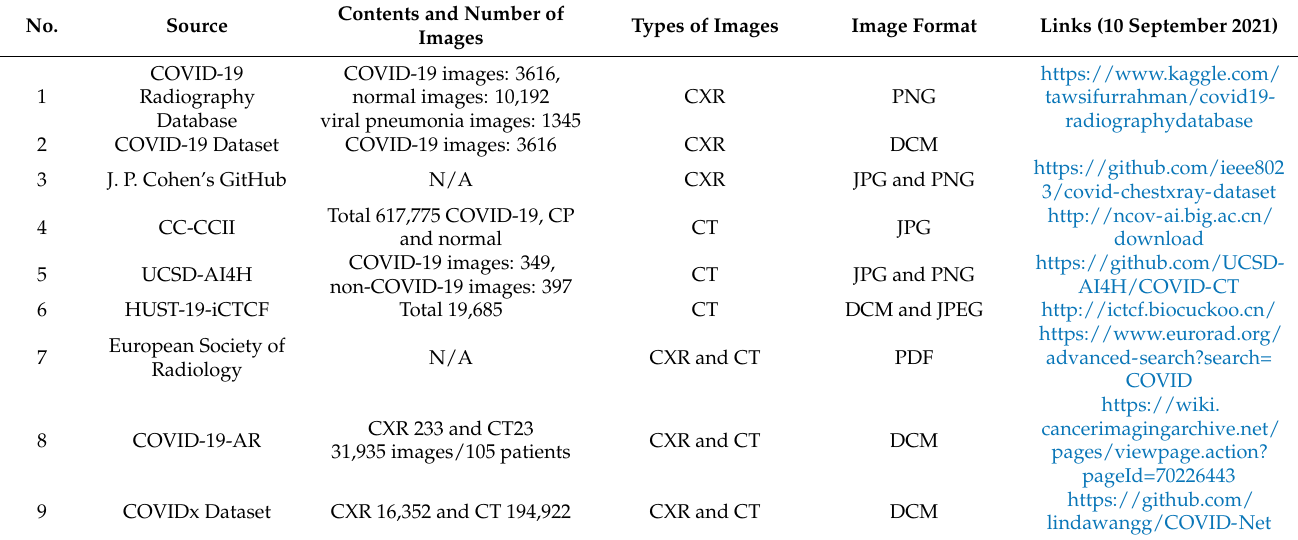
Table 2. Partial available open-source datasets of COVID-19 radiology images